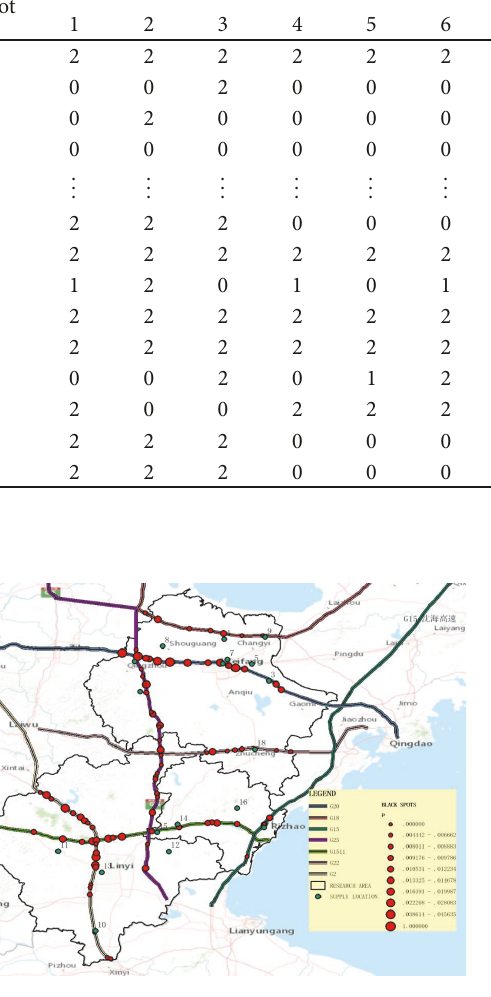
Figure 5: The map with final black spots.